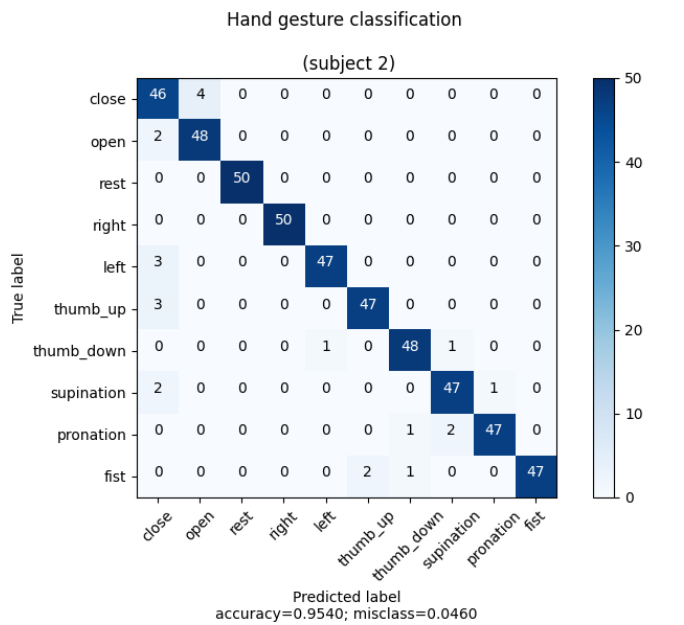
Figure A2. Confusion matrix of a subject who participated in data collection (subject